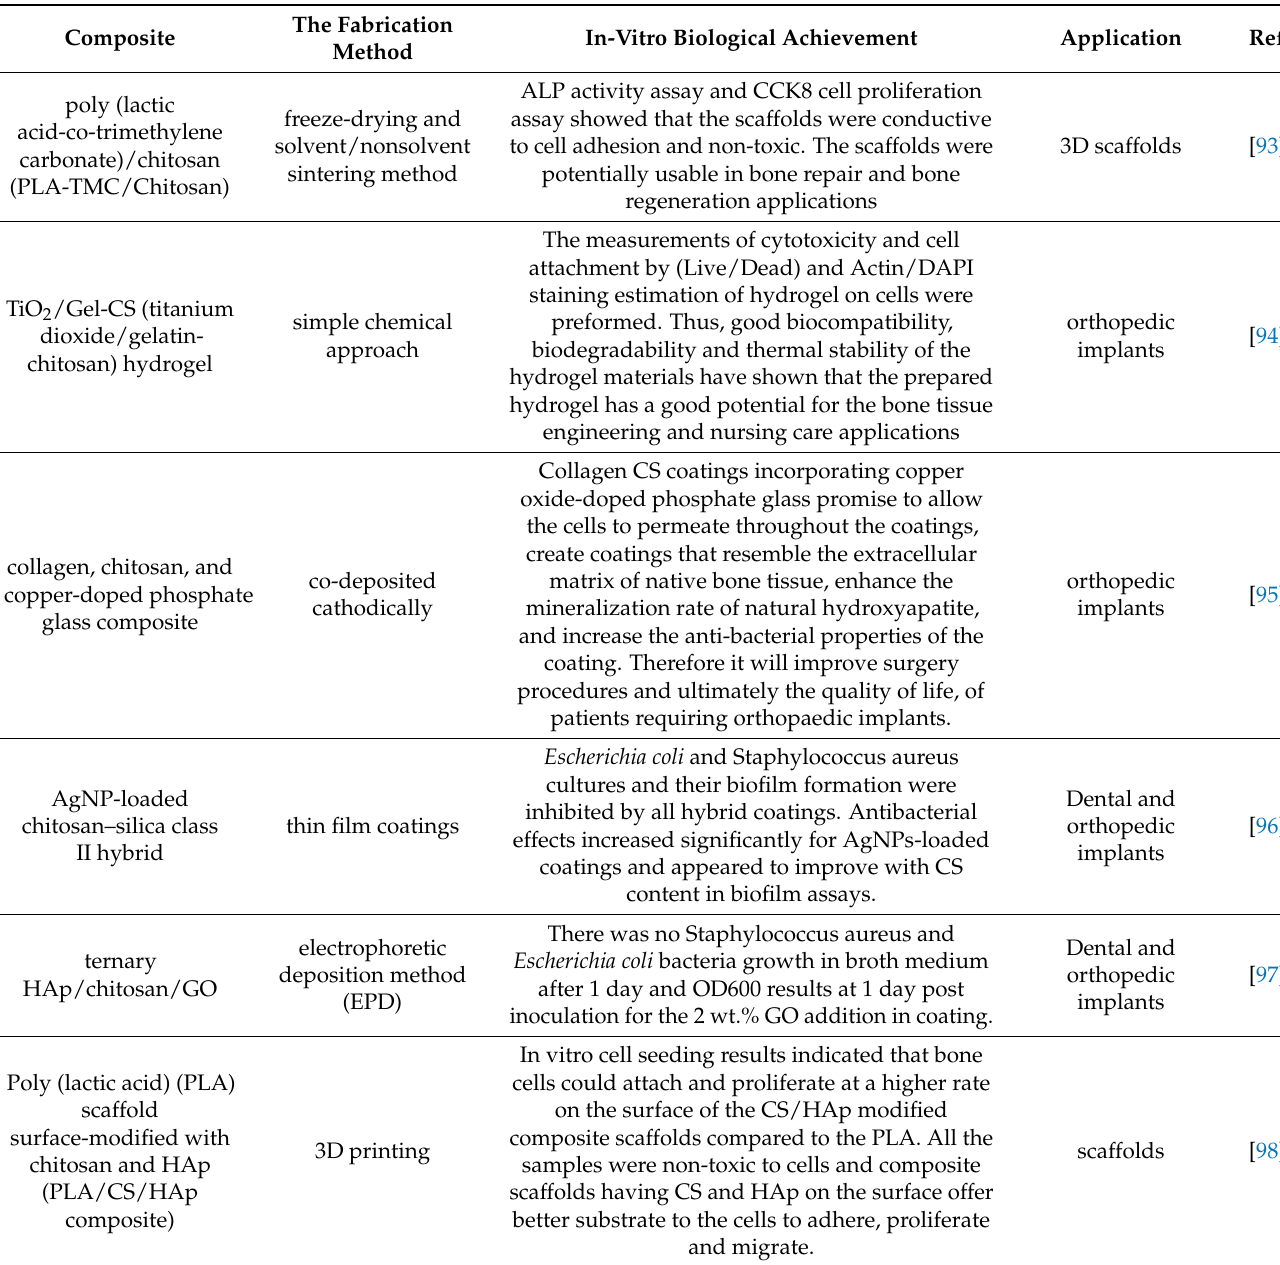
Table 1. A list of various chitosan composites for applications of implant and dental